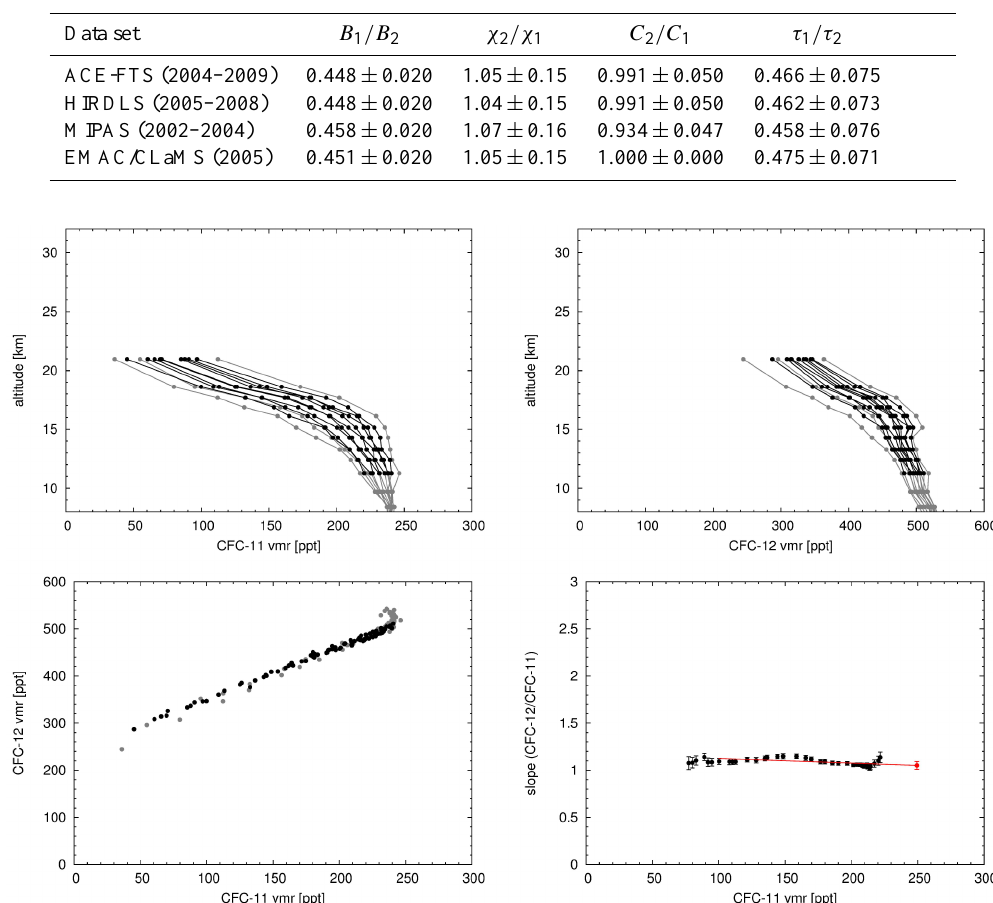
Table 1. Summary of input data for the calculation of CFC-11 / CFC-12 lifetime ratios.